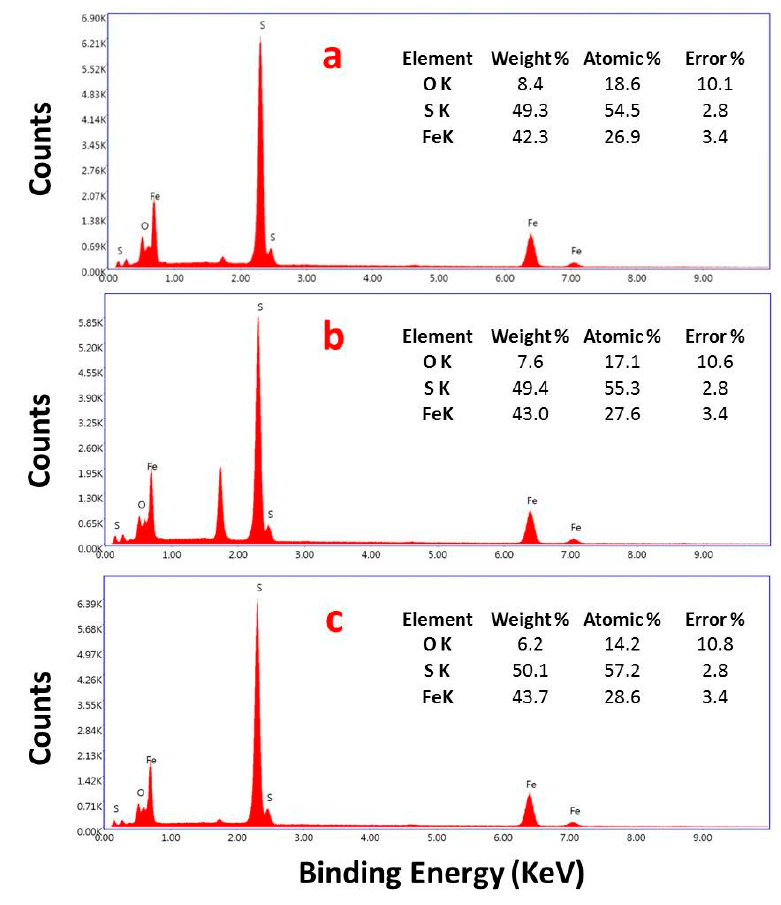
Figure 4. Energy-dispersive X-ray spectrum (EDS) of the as-synthesized pyrite nanocrystals with 80 mmol/L thiourea as the sulfur source at 24 ( a,b ), 72 ( c,d ), and 168 h ( e,f ), respectively.